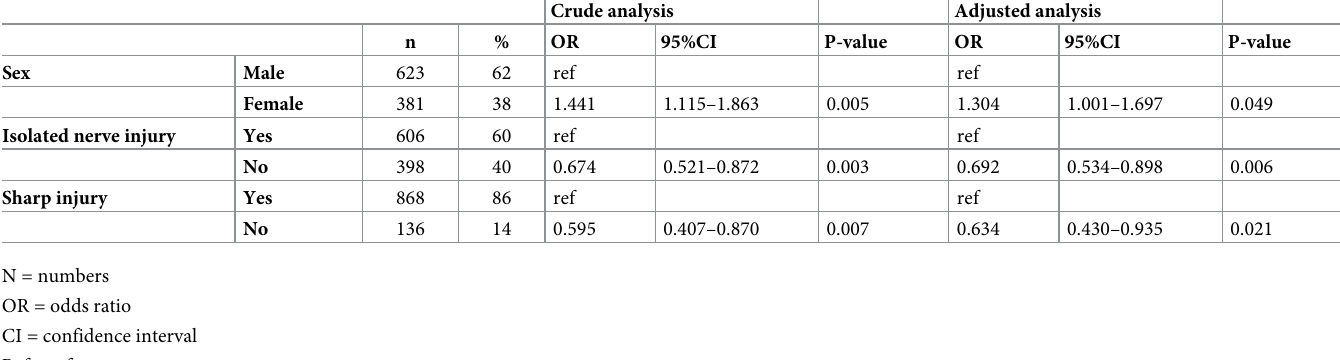
Table 3. Logistic regression analysing time from digital nerve injury to surgery adjusted for sex, type of injury and mechanism in 1004 patients treated surgically for a digital nerve injury in Stockholm, Sweden, 2012–2018.